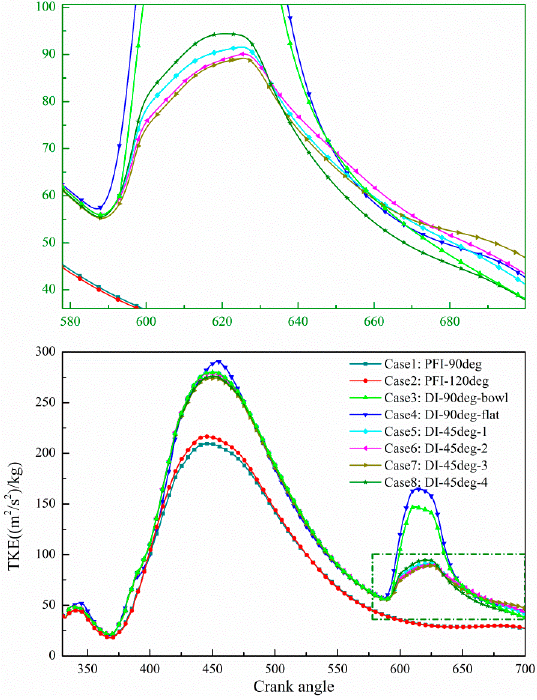
Figure 4. Turbulent kinetic energy and enlarged diagram of Cases 1–8.